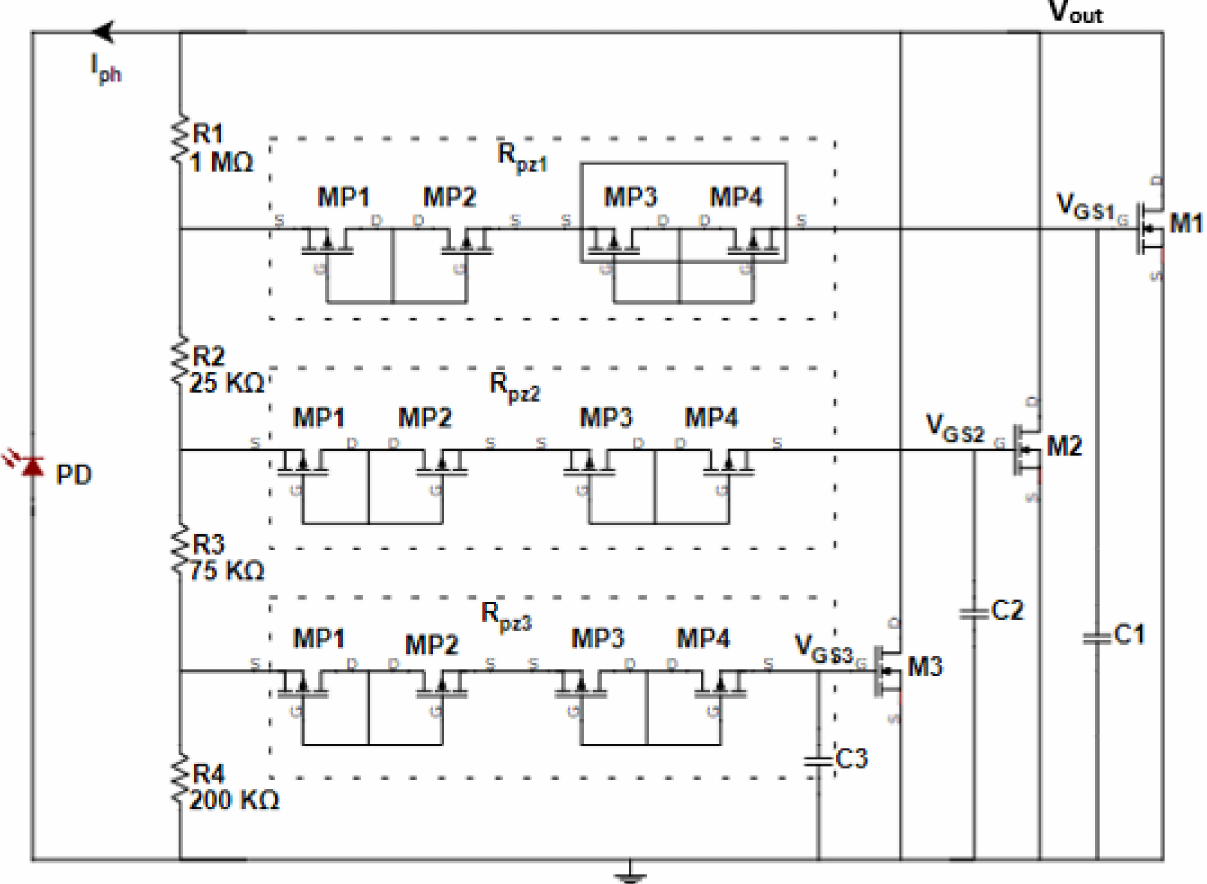
Figure 1. The proposed photocurrent sensory circuit with